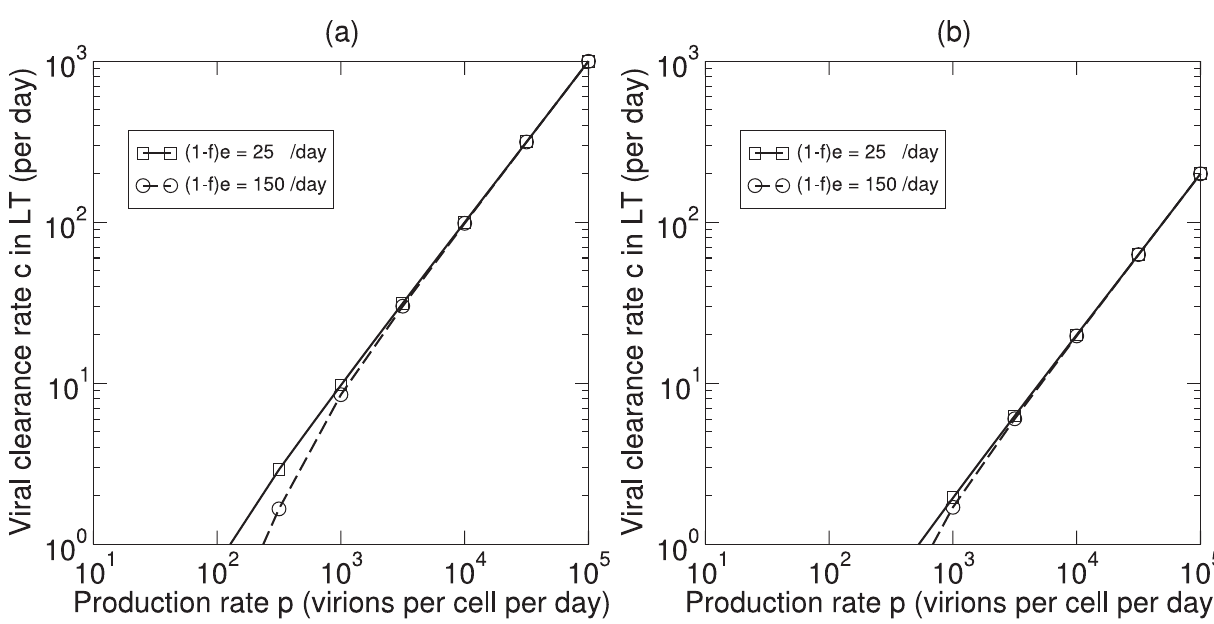
Figure 1. Viral clearance in the lymphoid tissue, c , as a function of the production rate p , given by Eq. (14), for a typical patient with I ~ 10 8 cells, V P ~ 10 8 , V L ~ V F z V B ~ 10 11 particles, and the indicated clearance rates via the blood, ( 1 { f ) e . In (a) 90% of the virus in lymphoid tissue is associated with FDCs, i.e., V F ~ 10 10 , and in (b) this is 50%, i.e., V F ~ 5 | 10 10 .